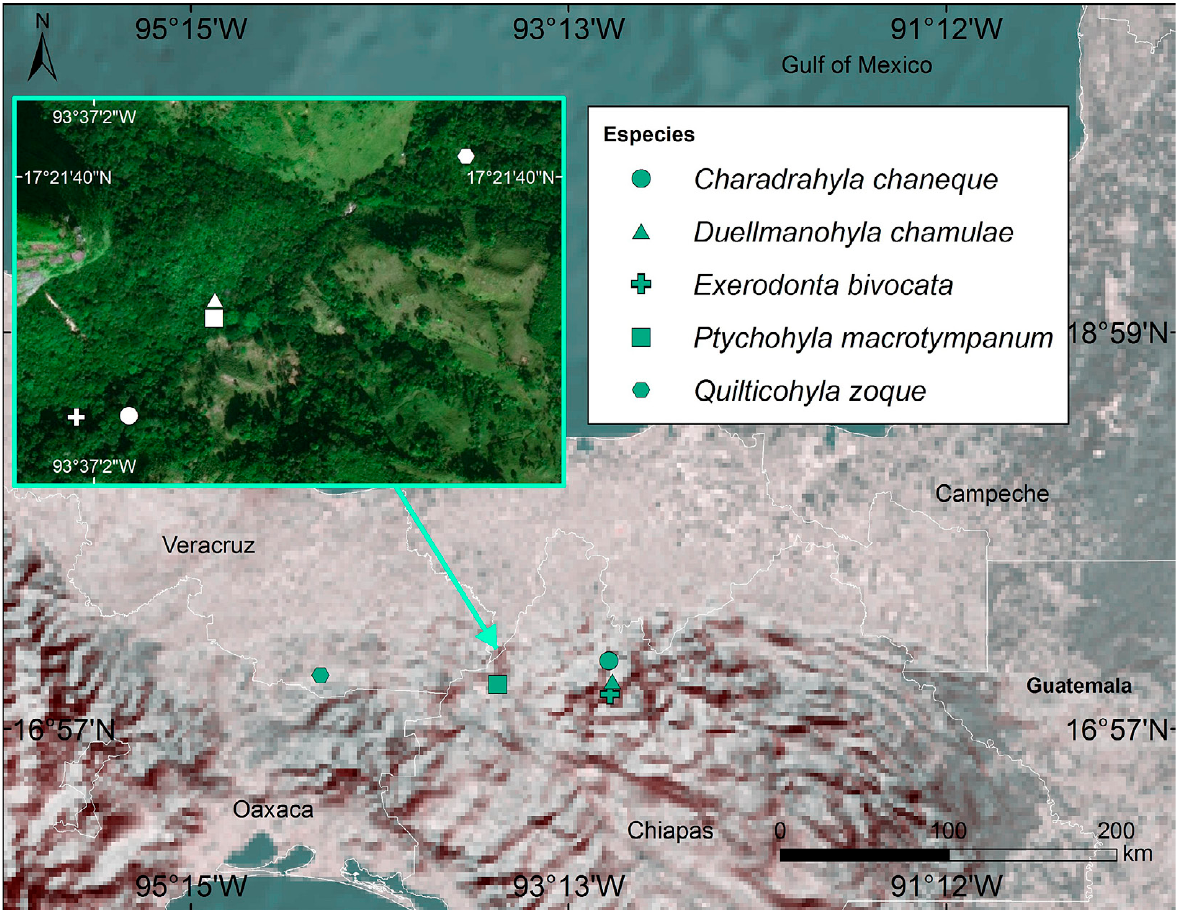
Figure 1. New distribution records of hylids in Tabasco state, Mexico. The white points represent new records from the state of Tabasco and the green points indicate the nearest historical